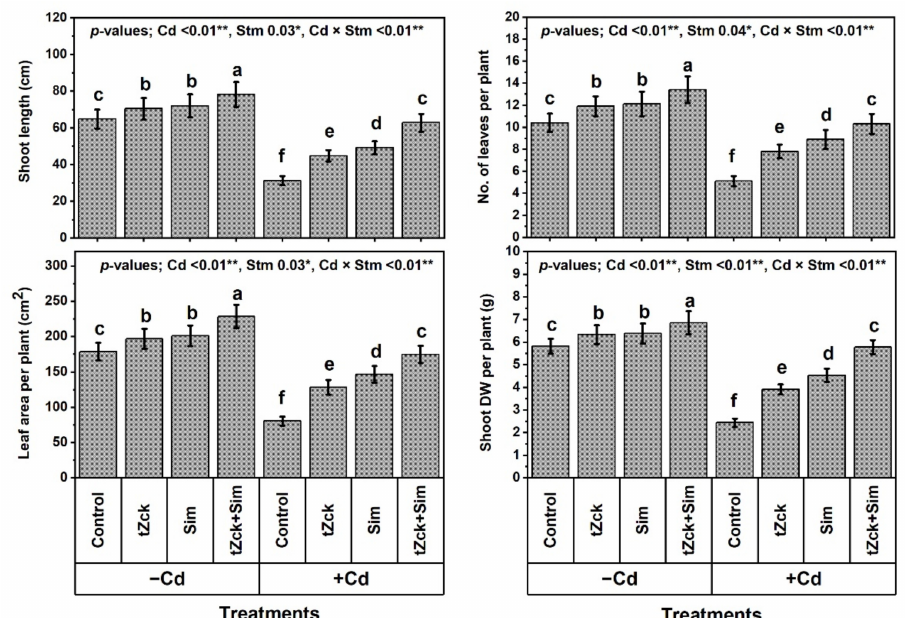
Figure 1. Growth traits of wheat (cv. Sakha 93) treated with two stimulators (Stm) i.e., silymarin (Sim; 0.5 mM) and trans -zeatin-type cytokinin ( t Zck; 0.05 mM) under cadmium (Cd; 0.6 mM) stress. The same letters with mean values ± SE in each plot indicate non-significant differences based on the LSD test ( p ≤ 0.05). * and ** refer to significant difference at p ≤ 0.05 and p ≤ 0.01, respectively. t Zck; trans -zeatin-type cytokinin, Sim; silymarin, − Cd; without cadmium treatment, +Cd; cadmium treatment and Stm; stimulator.